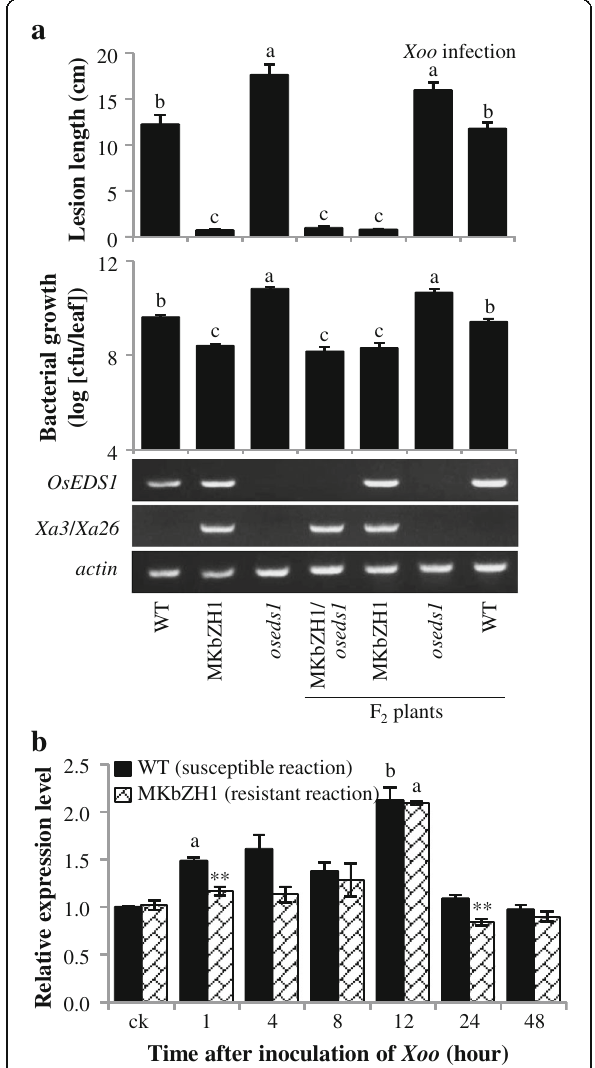
Fig. 5 OsEDS1 was not required for R -mediated resistance to Xoo . Data represent mean ± SE ( n = 11 to 15 for lesion length, and 3 for bacterial growth and gene expression). WT, wild-type Zhonghua 11; MKbZH1, transgenic line carrying R gene Xa3/Xa26 with the genetic background of Zhonghua 11. a The oseds1 did not influence Xa3/ Xa26 -mediated resistance. Bacterial growth were analyzed at 12 days after Xoo inoculation. Different letters above bars indicate significant differences at P <0.01 by the one-way ANOVA test. b OsEDS1 showed similar expression patterns in both resistant and susceptible reactions. Two-tail student ’ s t-test. The “ a ” or “ b ” above bar indicate significant differences between non-inoculated control (ck) plants and inoculated plants at P <0.01 or P <0.05, respectively. The ** above bar indicate significant differences between WT and MKbZH1 plants after the same treatment at P